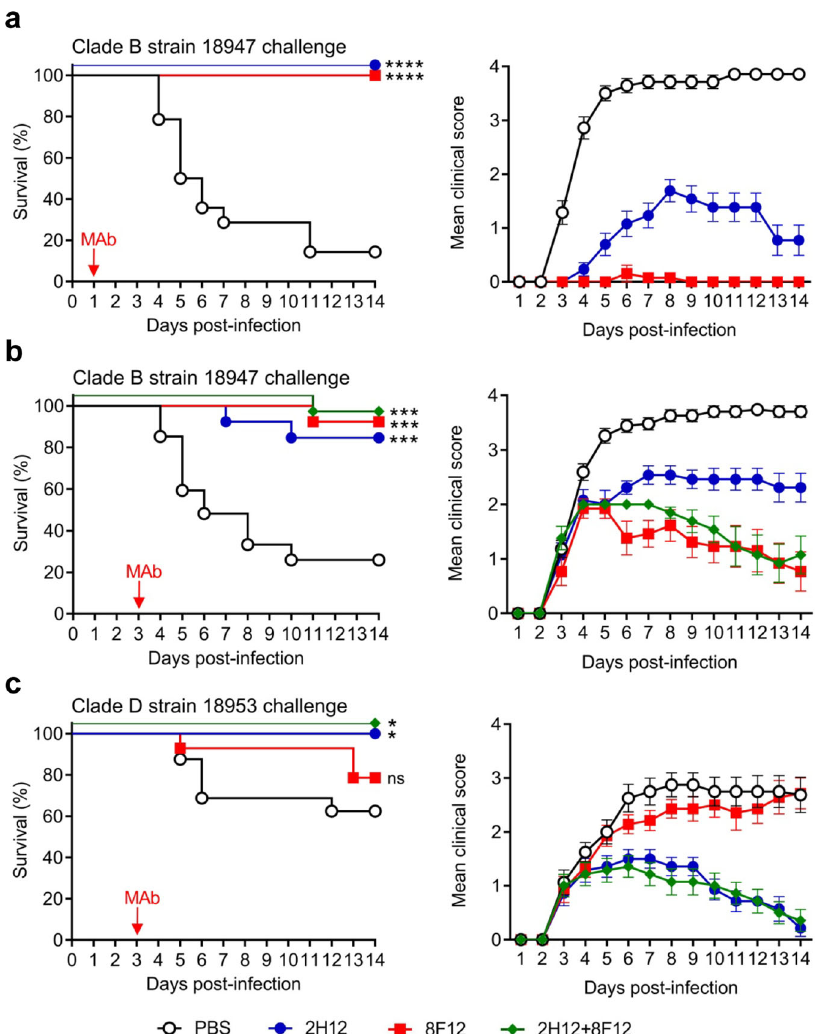
Fig. 2 Therapeutic ef fi cacy of the MAbs against EV-D68 infection in mice. One-day-old ICR mice ( n = 13 – 27/group) were inoculated intraperitoneally (i.p.) with strain 18947 ( a – b ) or strain 18953 ( c ). The suckling mice were i.p. injected with PBS, 10 µ g/g of 2H12, 10 µ g/g of 8F12, or a mixture of both MAbs (10 μ g/g of each MAb) at 1 day post infection (dpi) ( a ) or 3 dpi ( b , c ) and were then monitored daily for survival and clinical score. Red arrows indicate the time points of MAb administration. Clinical scores were graded as follows: 0, healthy; 1, lethargy and reduced mobility; 2, limb weakness; 3, limb paralysis; 4, death. Note that to prevent overlap, the overlapping data sets in left panels (survival curves) were nudged by 5 units in the Y direction. Survival rates of antibody-treated mice were compared with the mice in the PBS control group. Statistical signi fi cance was determined by Log-rank (Mantel-Cox) test and was indicated as follows: ns., no signi fi cant difference ( p ≥ 0.05); *, p < 0.05; ***, p < 0.001; ****, p < 0.0001. In panel ( a ), p value between the 2H12 or 8F12 group and the PBS control group is below 0.0001. In panel ( b ), p value between the 8F12 or 2H12 + 8F12 group and the PBS group is 0.0001; p value between the 2H12 group and the PBS group is 0.0007. In panel ( c ), p value between the 2H12 or 2H12 + 8F12 group and the PBS group is 0.0121; p value between the 8F12 group and the PBS group is 0.2958. All error bars represent